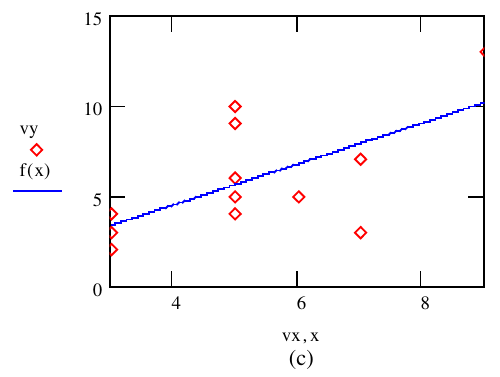
Fig 4. Mutual regression dependencies between: (a) - the AC Power Inverter (X) and the Transformer Rectifier Unit; (b) - the AC Power Inverter (X) and the Battery (Y); and (c) - the Transformer Rectifier Unit (X) and Battery Correlation coefficients are r = 0.6291, r = 0.7113, and xz xy r = 0.6283. Then a and b will be yz a = 0.4783 and b = 0.6629.